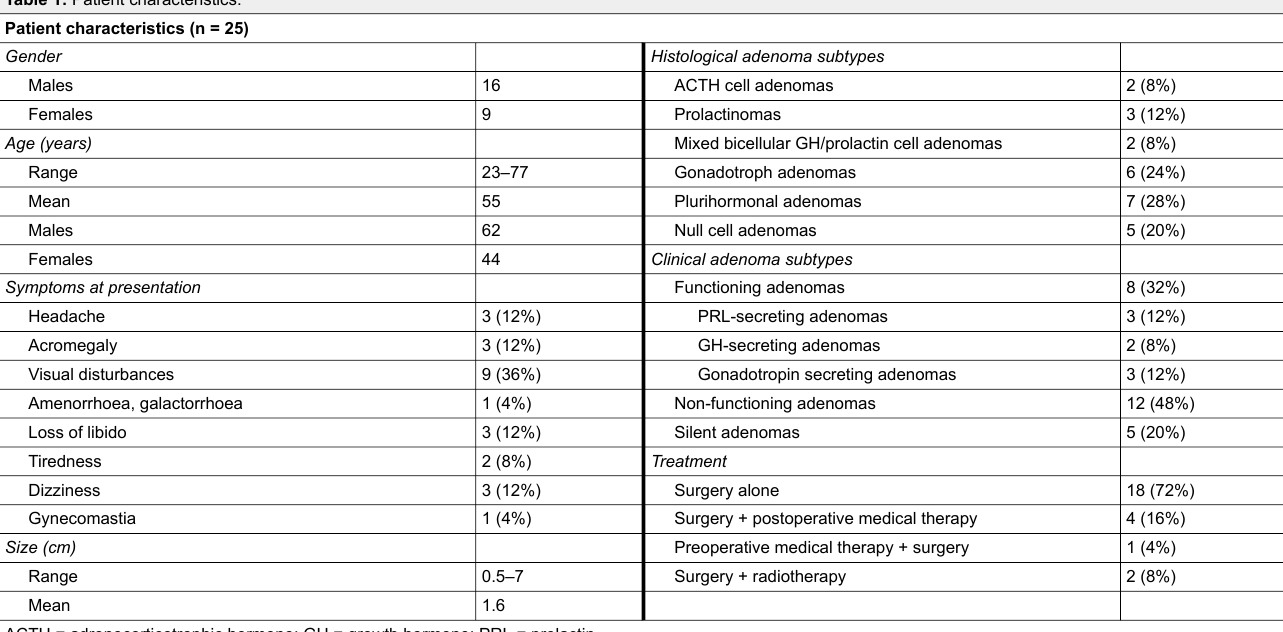
Table 1: Patient characteristics. Patient characteristics (n =